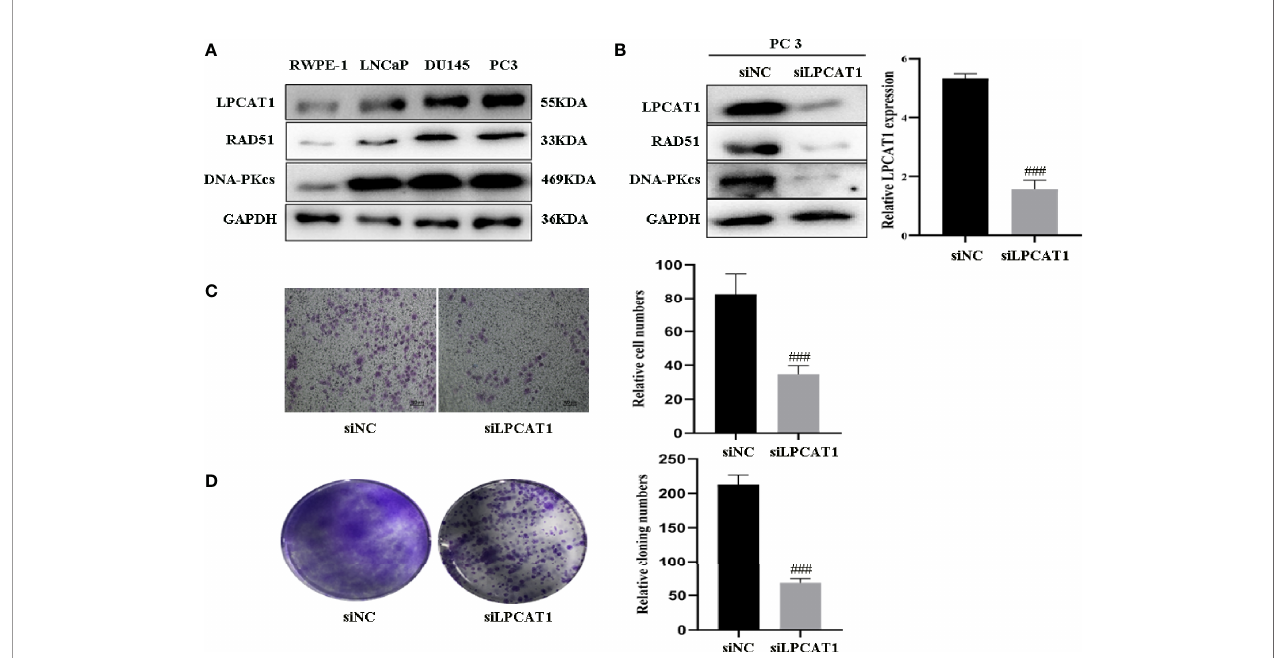
FIGURE 8 | Downregulation of LPCAT1 suppressed PCa cell proliferation and migration (A) LPCAT1, DNA-PKcs, RAD51 were highly expressed in PCa cell lines (PC3, DU145, LnCaP) when compared to RWPE-1 (normal prostate epithelial cell). (B) Inhibition of LPCAT1 downregulated DNA-PKcs and RAD51 expressions in PC-3 cells. (C, D) Cloning formation and migration assays showed that downregulation of LPCAT1 suppressed PC-3 cell proliferation and migration. Data are presented as mean ± SD. ### P <